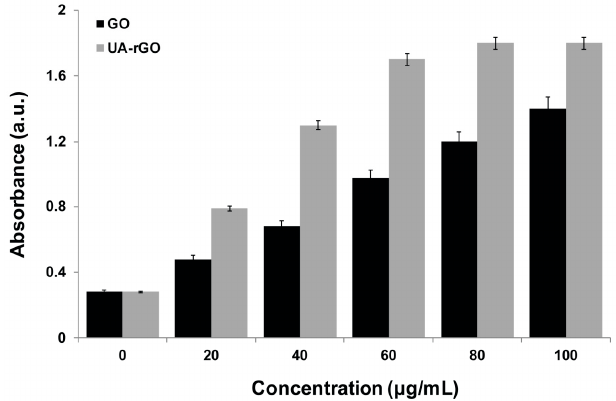
Figure 9. GO and UA-rGO induce release of LDH to the culture supernatant of human ovarian cancer cells. LDH activity was measured at 490 nm using the LDH cytotoxicity kit. The results are expressed as the mean ± standard deviation of three independent experiments. There was a significant difference in LDH activity of GO- and UA-rGO-treated cells compared to the untreated cells by the Student’s t -test ( p < 0.05).